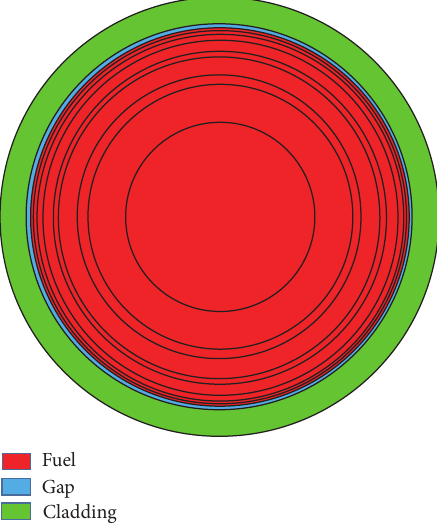
Figure 2: Radial profile of a fuel-cladding system with fuel region divided into 9 rings.